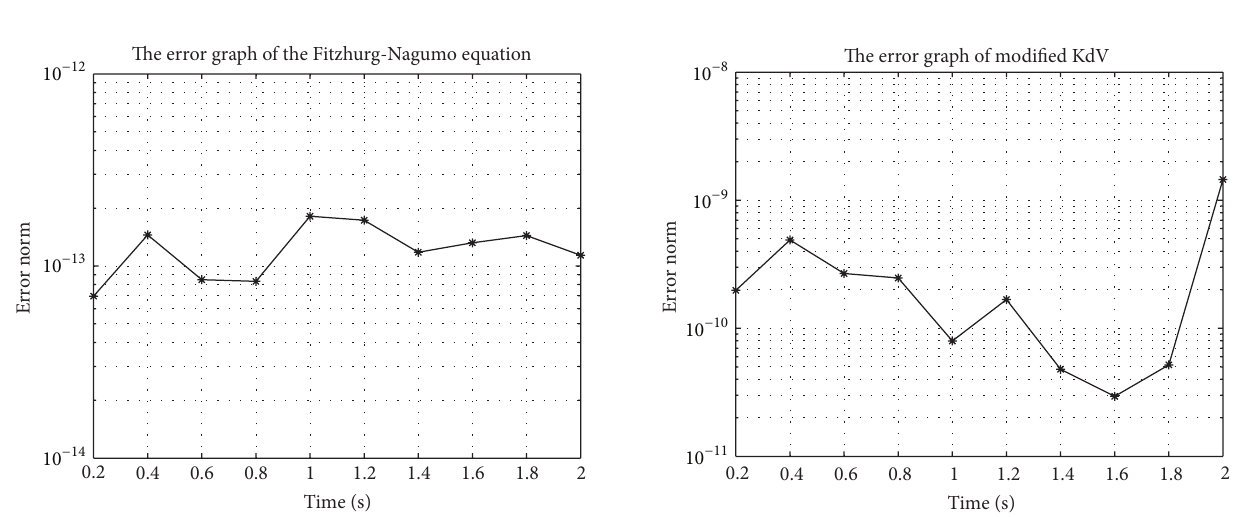
Figure 11: Modified KdV-Burger equation error graph.